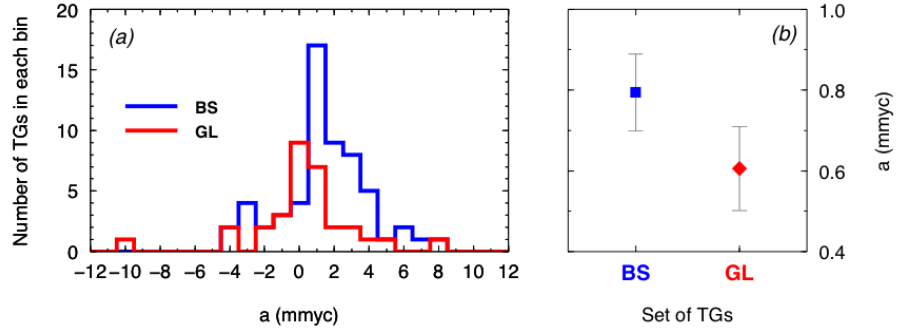
Figure 2. Distribution of observed sea-level accelerations. (a) Sea-level accelerations observed for the Baltic Sea (BS, blue) and the global (GS, red) sets of tide gauges. (b) Average sea-level accelerations for the two sets and their standard deviations. For BS and GL, the accelerations have average values of (0.8 ± 0.1) and (0.6 ± 0.1) mmyc, respectively. Their difference defines the anomalous sea-level acceleration N (0.2 ± 0.2)